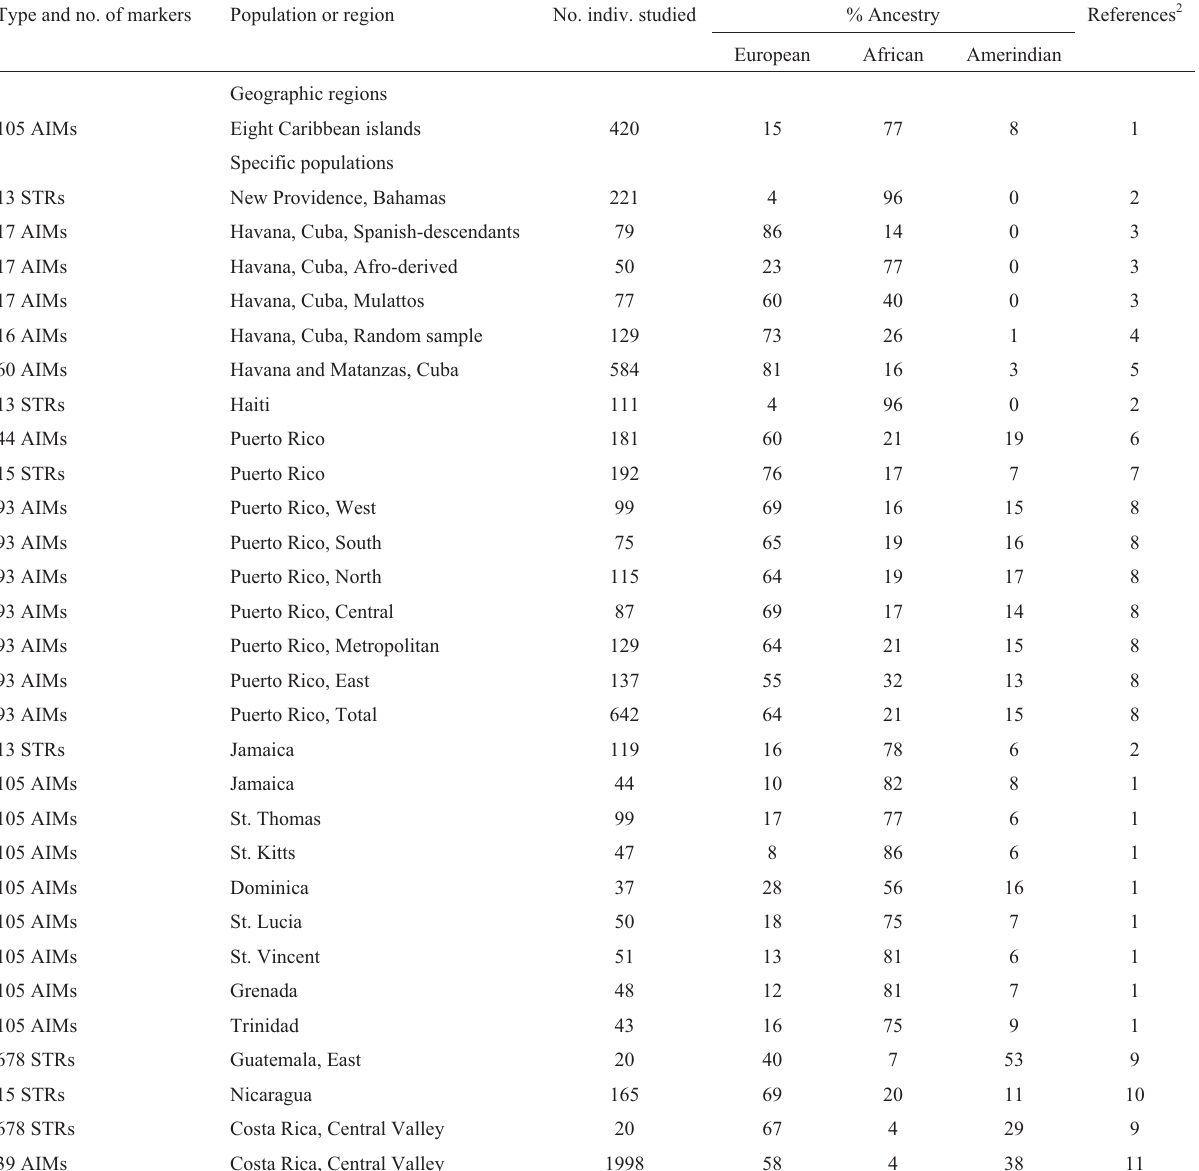
Table 2 - Molecular autosome estimates of parental continental ancestry in different segments of the Middle American populations with the exception of Mexico 1 . Type and no. of